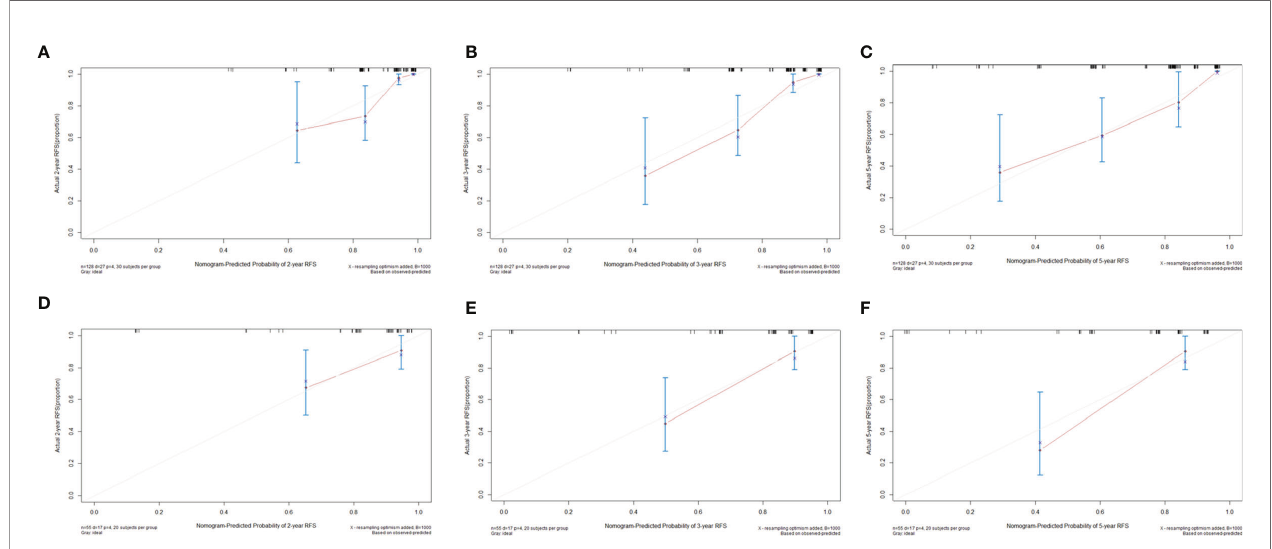
FIGURE 6 | Calibration curves to predict (A) 2-year, (B) 3-year, and (C) 5-year recurrence-free survival rates in the training cohort and (D) 2-year, (E) 3-year, and (F) 5-year recurrence-free survival rates in the validation